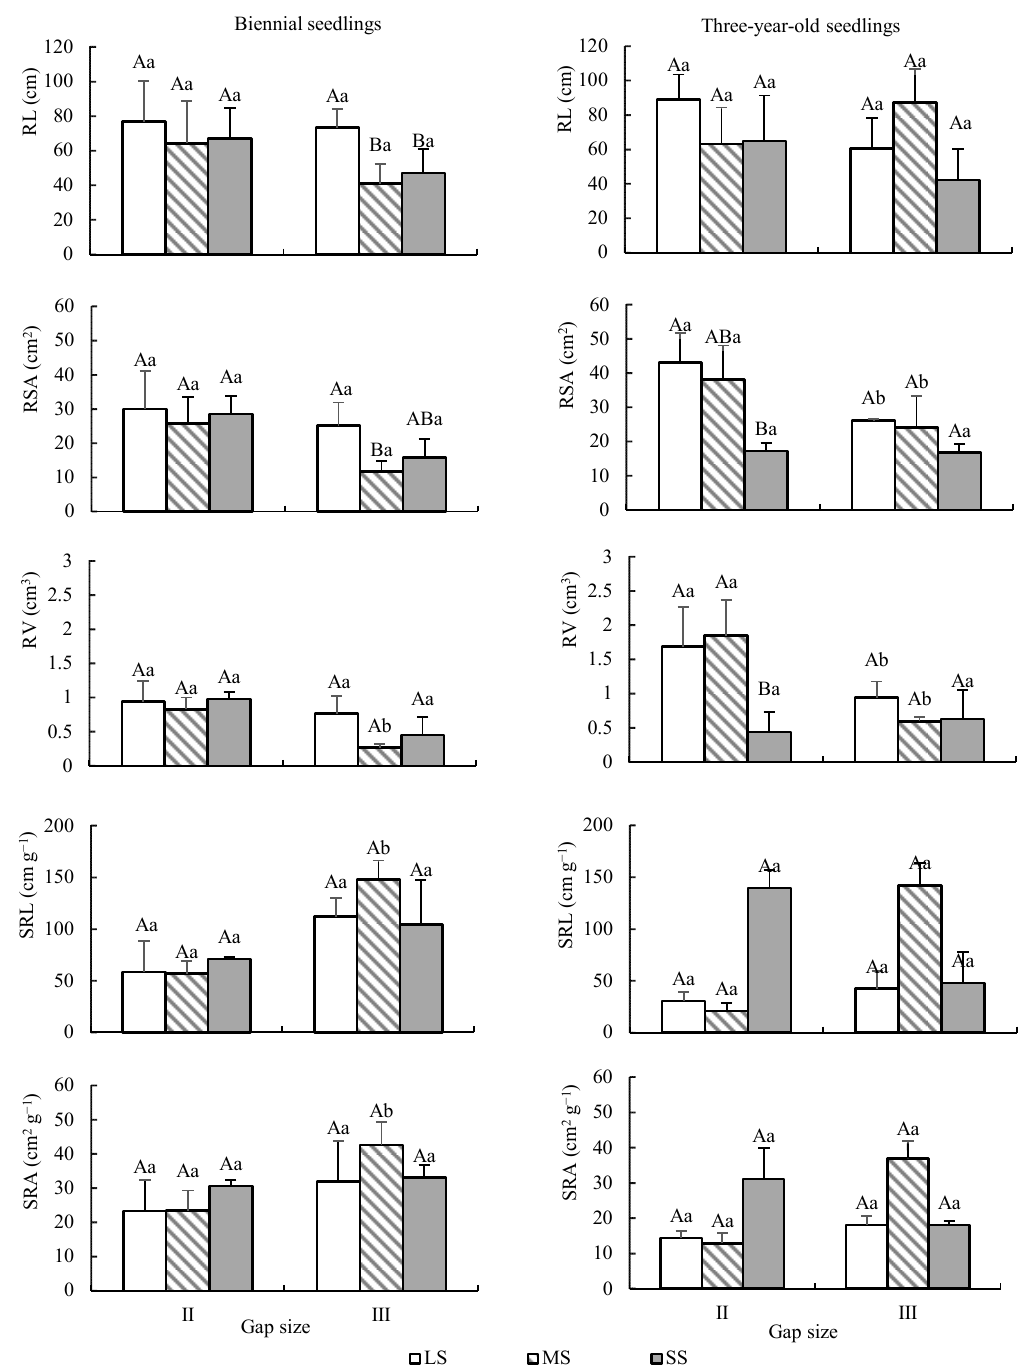
Figure 8. Dynamic changes of root characteristics of Quercus acutissima seedlings from different sizes of seeds under different forest gaps. LS: large seed; MS: medium seed; SS: small seed. Different capital letters indicate that there is a significant difference between different seed size groups under the same gap ( p < 0.05), and different lower letters indicate that there is a significant difference between gaps under the same seed size ( p < 0.05).